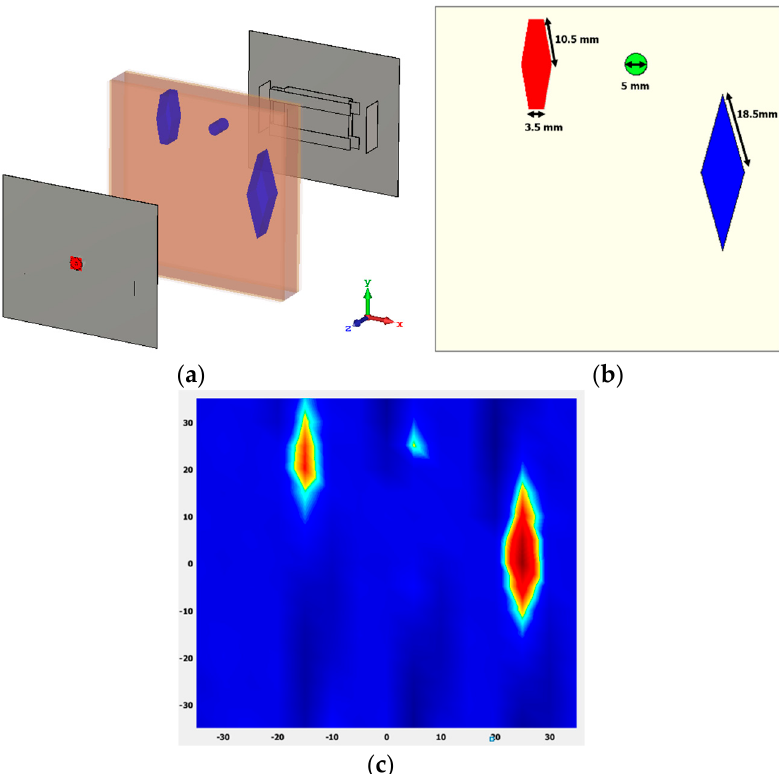
Figure 11. ( a ) Analysis setup; ( b ) tumor dimensions; ( c ) normalized imaging result of human tissue.